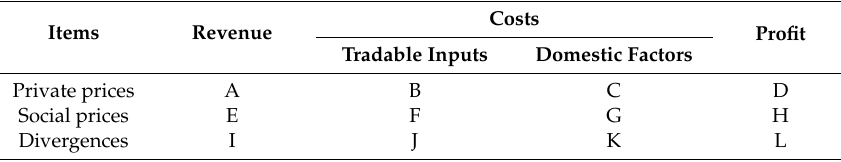
Table 1. Framework of Policy Analysis Matrix